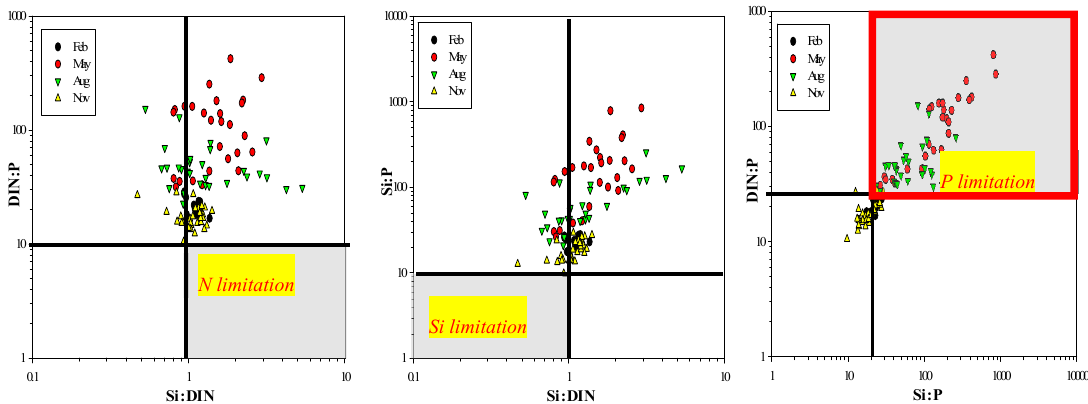
Figure 8. Scatter diagrams of atomic nutrient ratios at the euphotic depths (100%, 30%, and 1%) in the northern East China Sea, 2018.